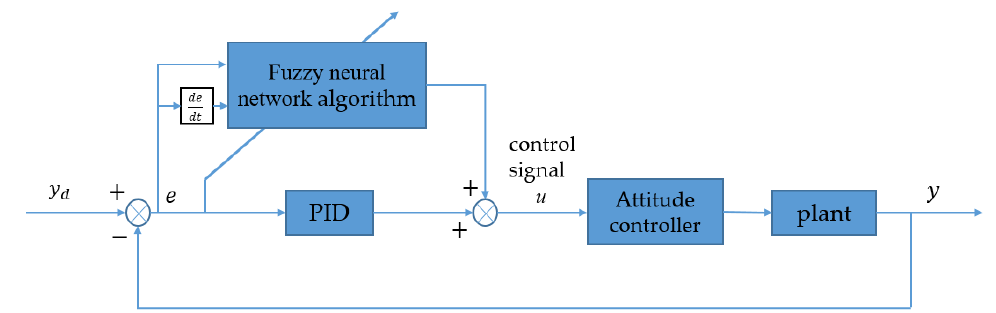
Figure 4. Structure of FNN-compensated PID position controller.